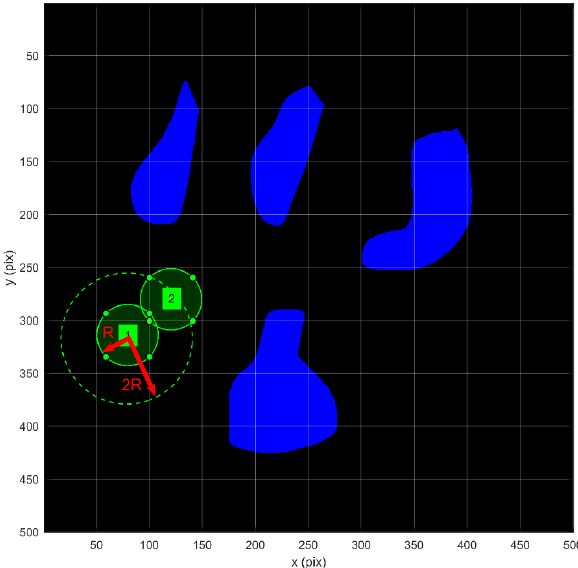
Figure 2. The sensor’s fields of view (#1 and #2, green color). Being at the center of area #1, in one iteration of time the sensor can move to any point placed inside the circle of radius 2 R (green dashed line) including the point that determines the center of the field of view